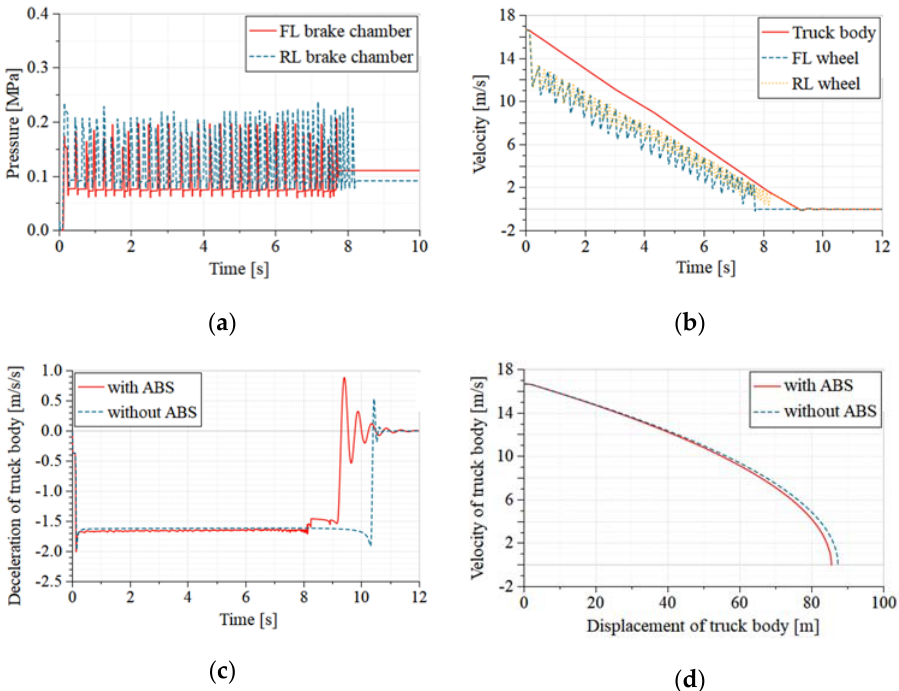
Figure 17. Braking characteristics on the road with adhesion coefficient 0.2. ( a ) Pressure of brake chamber; ( b ) velocity of truck body and wheels; ( c ) deceleration of truck body with ABS and without ABS; ( d ) velocity-displacement curves of truck body with ABS and without ABS.